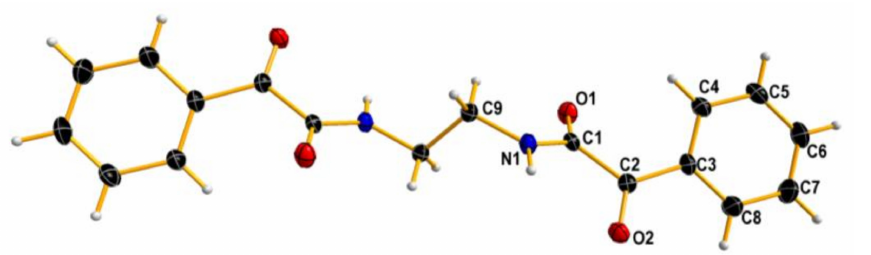
Figure 2. X-ray structure of 8 . Displacement ellipsoids are shown at the 50% probability level. Hydrogen atoms are depicted as small spheres of arbitrary radii.